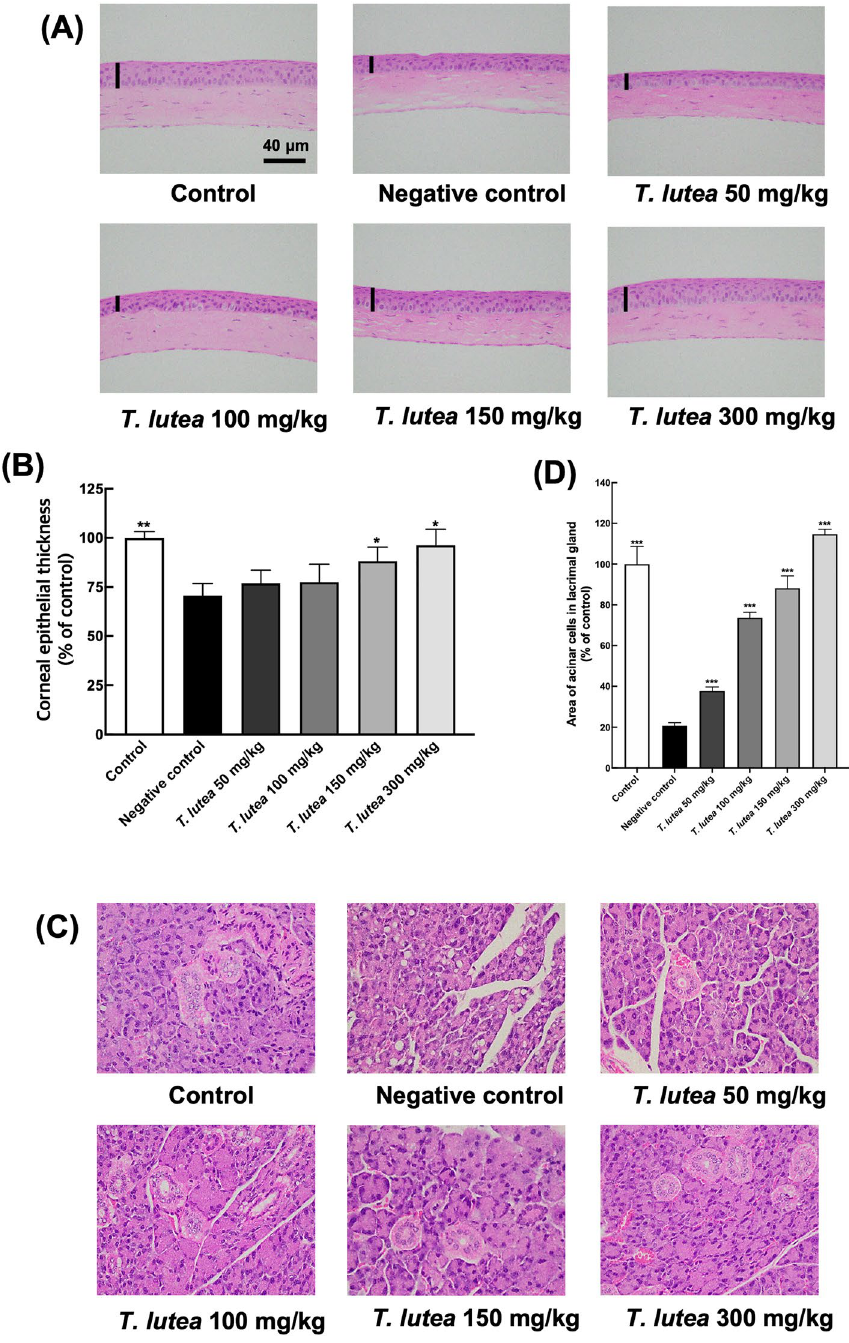
Figure 2. Corneal and lacrimal gland tissue changes following T. lutea ingestion. ( A ) H&E staining of whole- eye sections to demonstrate corneal epithelial thickness. ( B ) Representative graph of corneal thickness. ( C ) H&E staining of lacrimal gland tissue sections to demonstrate lymphocyte infiltration. ( D ) Quantity of acinar cell area in lacrimal gland tissues. Each treatment group consisted of 7 mice (n = 14 eyes and n = 7 lacrimal gland tissues). Data are represented as mean ± SEM (error bar). * p < 0.05, ** p < 0.01, and *** p < 0.001 versus negative control. Data were analyzed statistically using one-way ANOVA followed by Tukey’s post hoc